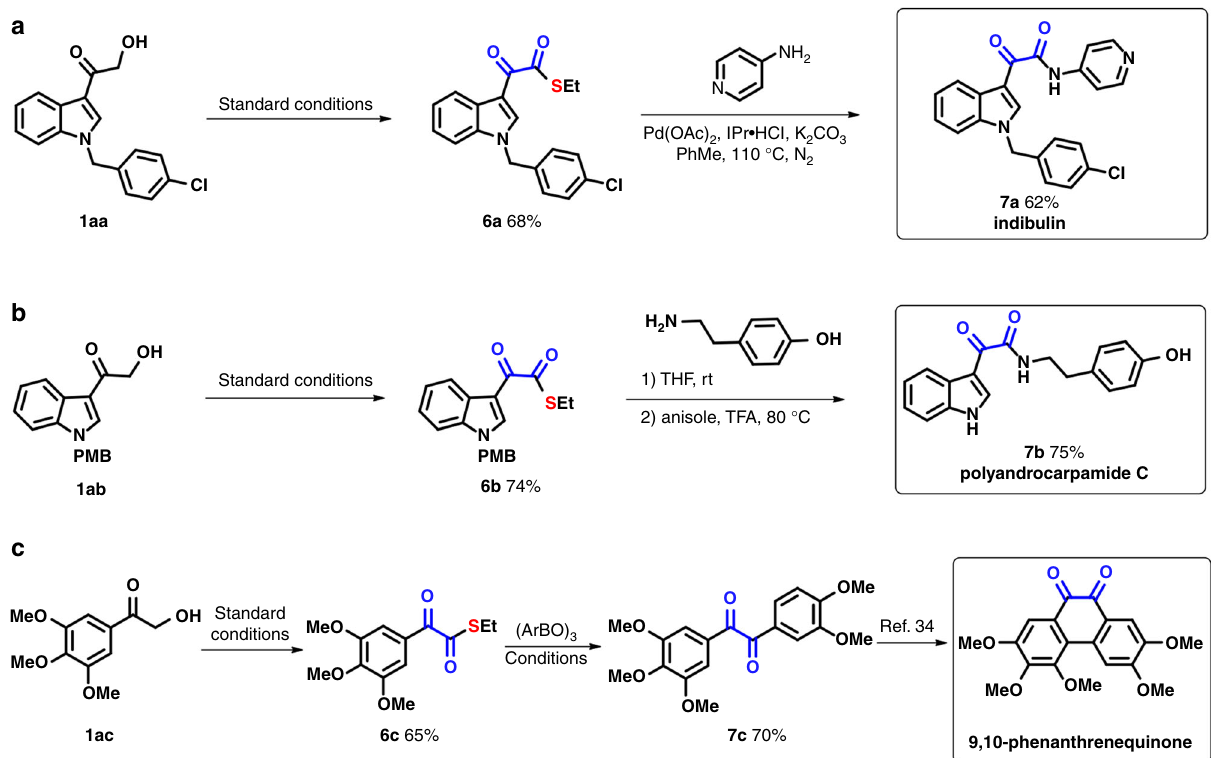
Fig. 5 Synthesis of dicarbonyl-containing drugs and natural products. a The synthesis of indibulin. b The synthesis of polyandrocarpamide C. c The synthesis of a